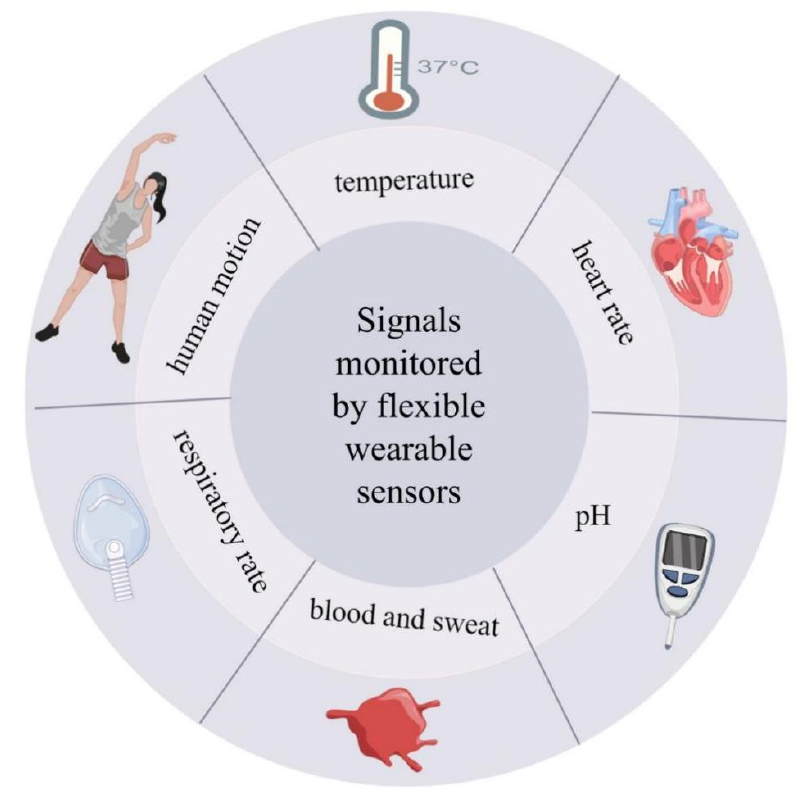
Figure 3. A visual summary of biological signals.